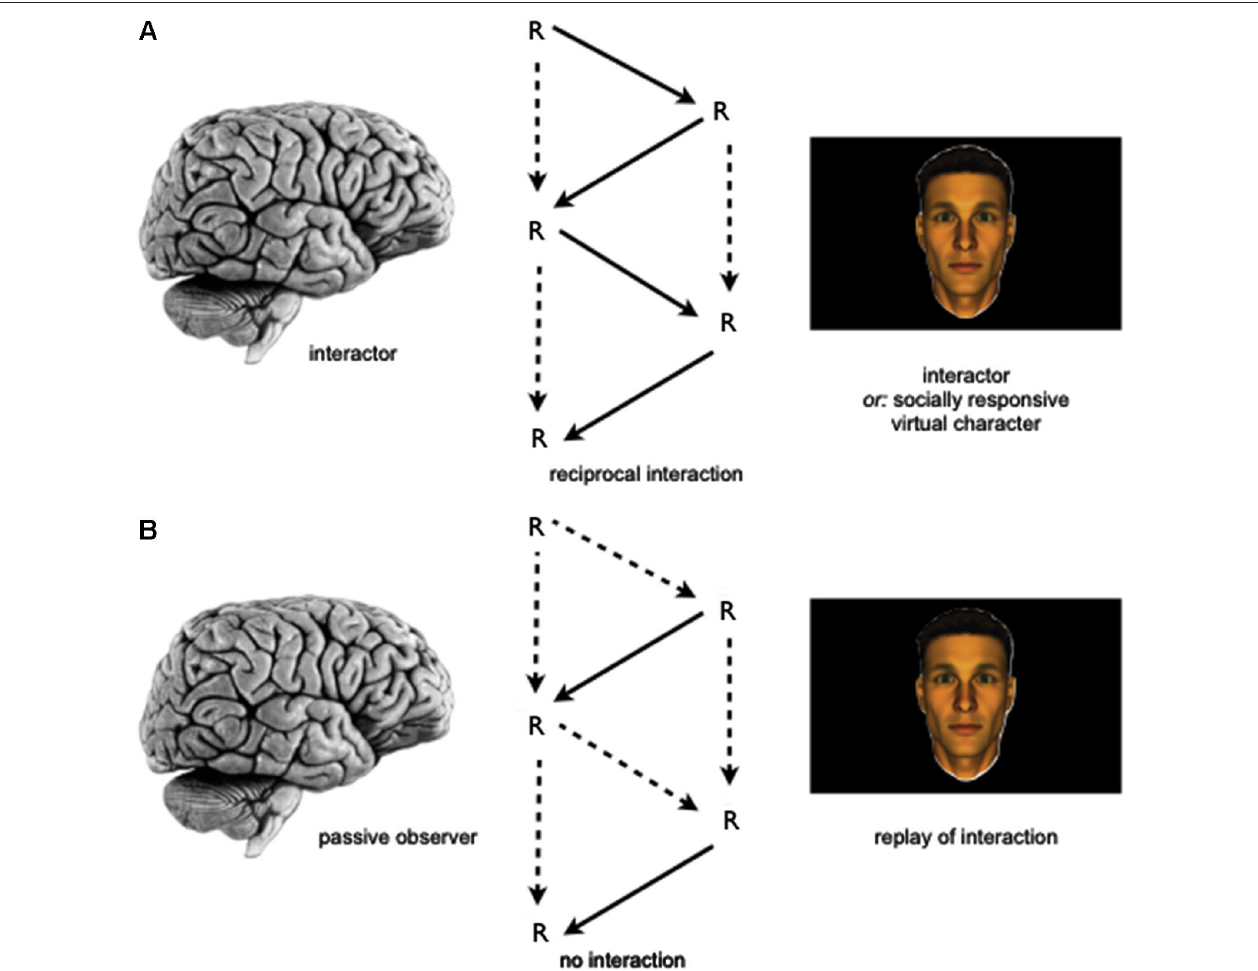
interaction task are presented to a participant, who is asked to perform the same task, but rely upon the gaze behavior shown to him on the video screen. Here, again the participant’s brain ( left ) is investigated by means of neuroimaging to allow (e.g.,) for a group-based comparison between the neural correlates of social interaction and observation. Legend: R: (re-) actions performed by agents. Dotted lines in schematic depiction of interaction contingencies indicate the absence or relatively decreased influence of actions on oneself (vertical arrows) or the other (oblique arrows), while solid lines indicate the presence of such influences. The temporal sequence of the social interaction is shown from top to